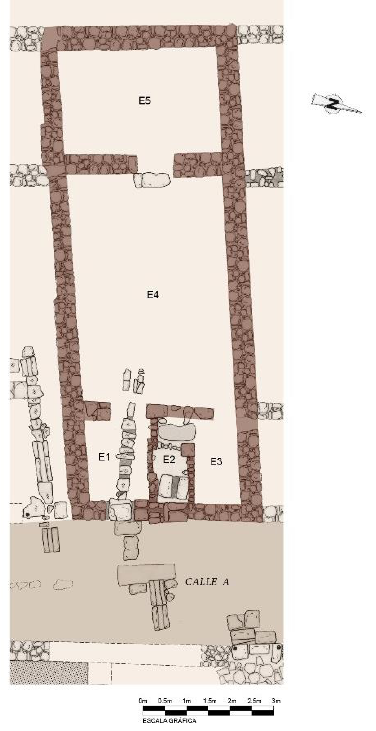
Figure 3. House 11. Plan and room distribution.